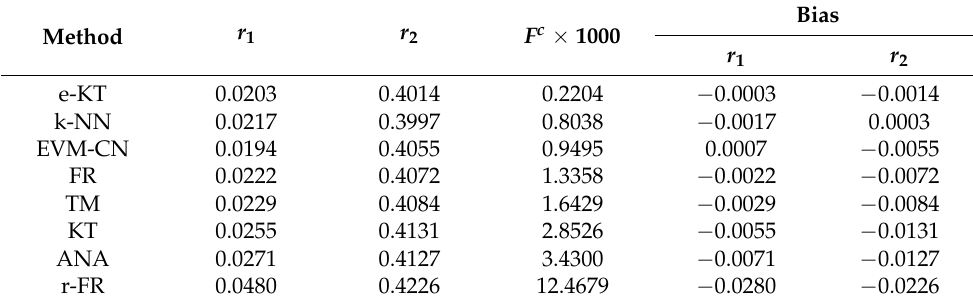
Table 12. Reactivity ratios obtained in the imposed conditions of LC1.